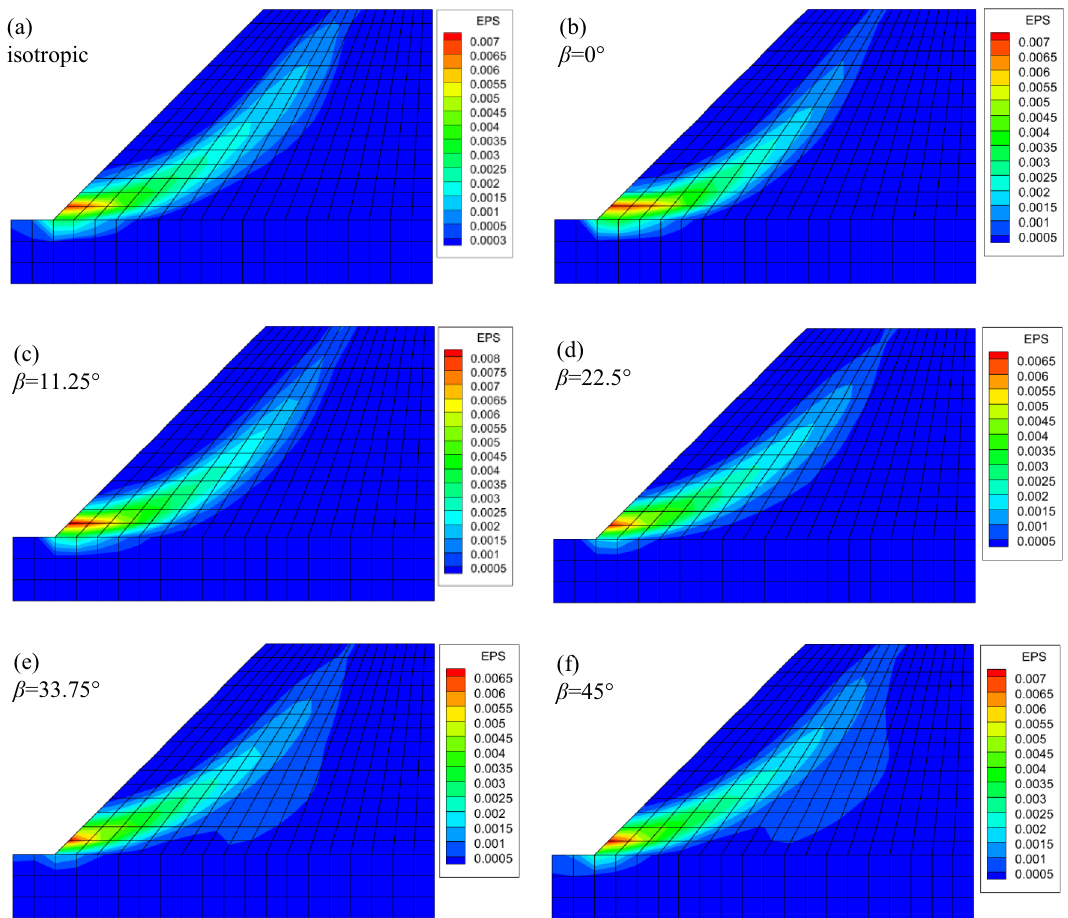
Figure 9. Effective plastic strain nephograms of slopes for isotropic and anisotropic [( b )–( f ), n = 0.707] conditions: ( a ) isotropic( n = 1), F s = 1.03; ( b ) F s = 0.89; ( c ) F s = 0.825; ( d ) F s = 0.79; ( e ) F s = 0.81; ( f ) F s =